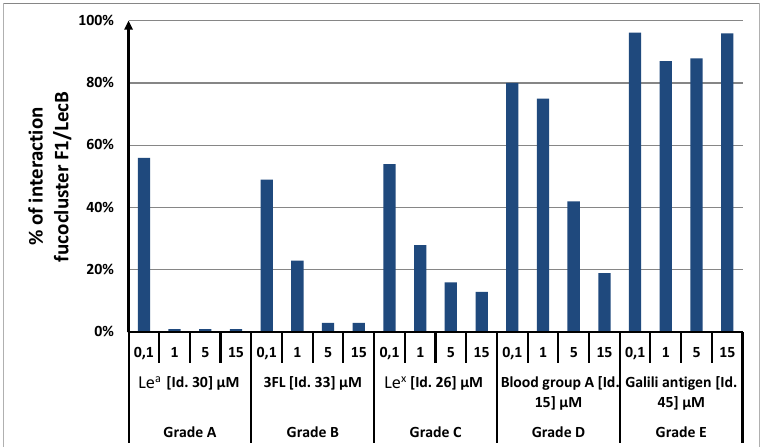
Figure 2. Examples of results obtained for five natural oligosaccharides. The reference fucocluster was F1 . On the y-axis, the fluorescent signal recorded after incubation of F1 with LecB and 0.1 µM of fucose was set at 100%. All other fluorescent signals were then normalized to that reference. (Le a : Lewis a tetraose, Galβ1-3(Fucα1-4)GlcNAcβ1-3Gal; 3FL: 3-Fucosyllactose, Galβ1-4(Fucα1-3)Glc; Le x : Lewis x triose, Galβ1-4( Fucα1-3)GlcNAcβ1-3Gal; Blood group A: A trisaccharide antigen, GalNAc α 1-3(Fuc α 1-2)Gal; Galili antigen: Galili pentasaccharide, Galα1-3(Galβ1-4GlcNAcβ1-3) 2 Galβ1-4Glc); see supporting information S1). Table 1. Oligosaccharides selected for the synthesis of oligoglycoclusters. Structure Grade Id.